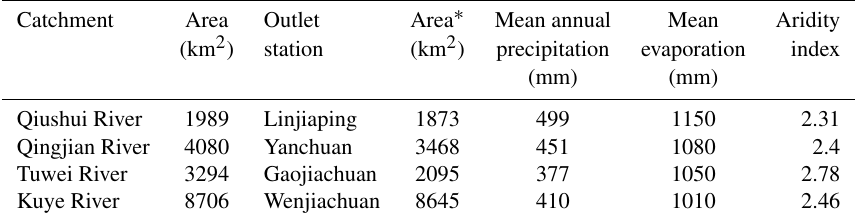
Table 1. Characteristics of the four catchments.